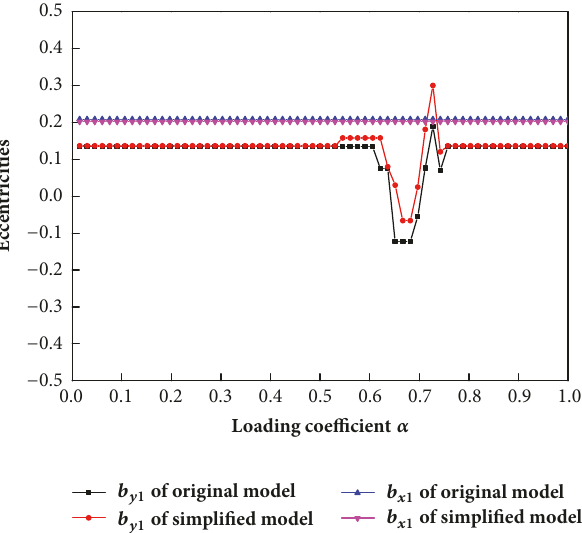
and b with 𝛼 . x 1 y 1